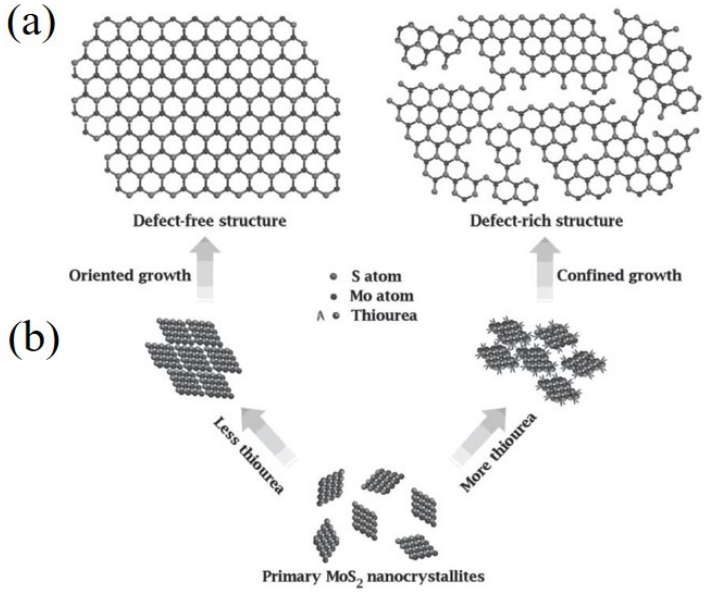
Figure 15. ( a ) Sketch of defect-free and defect-rich structures. ( b ) Synthetic processes of defect-free and defect-rich samples, respectively [30].